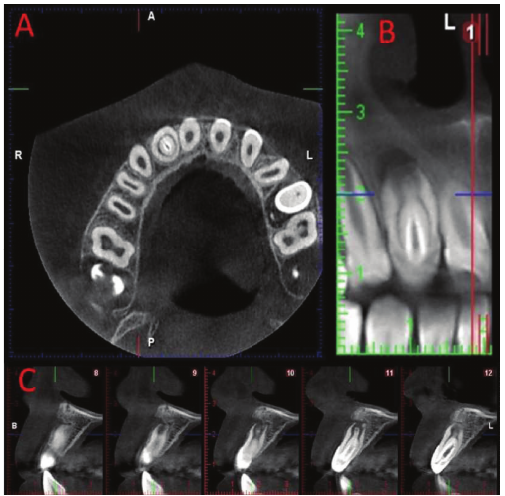
Figure 1: Three-dimensional image taken with